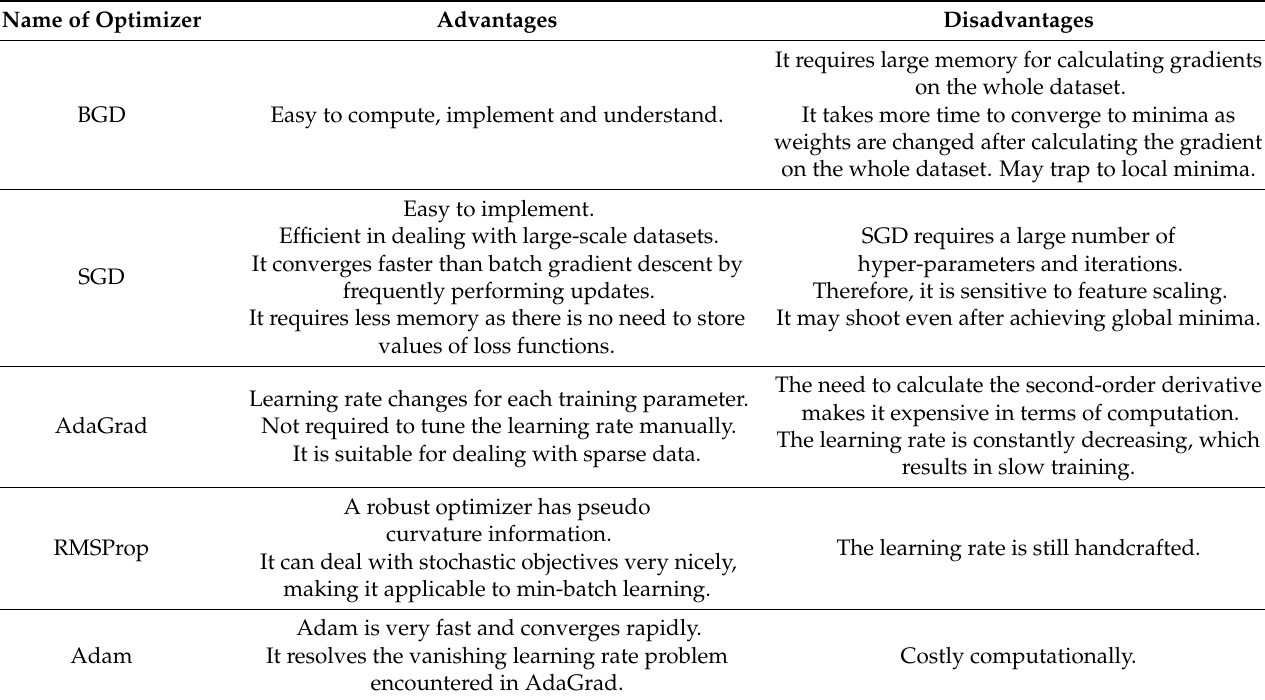
Table 4. Advantages and disadvantages of various optimization